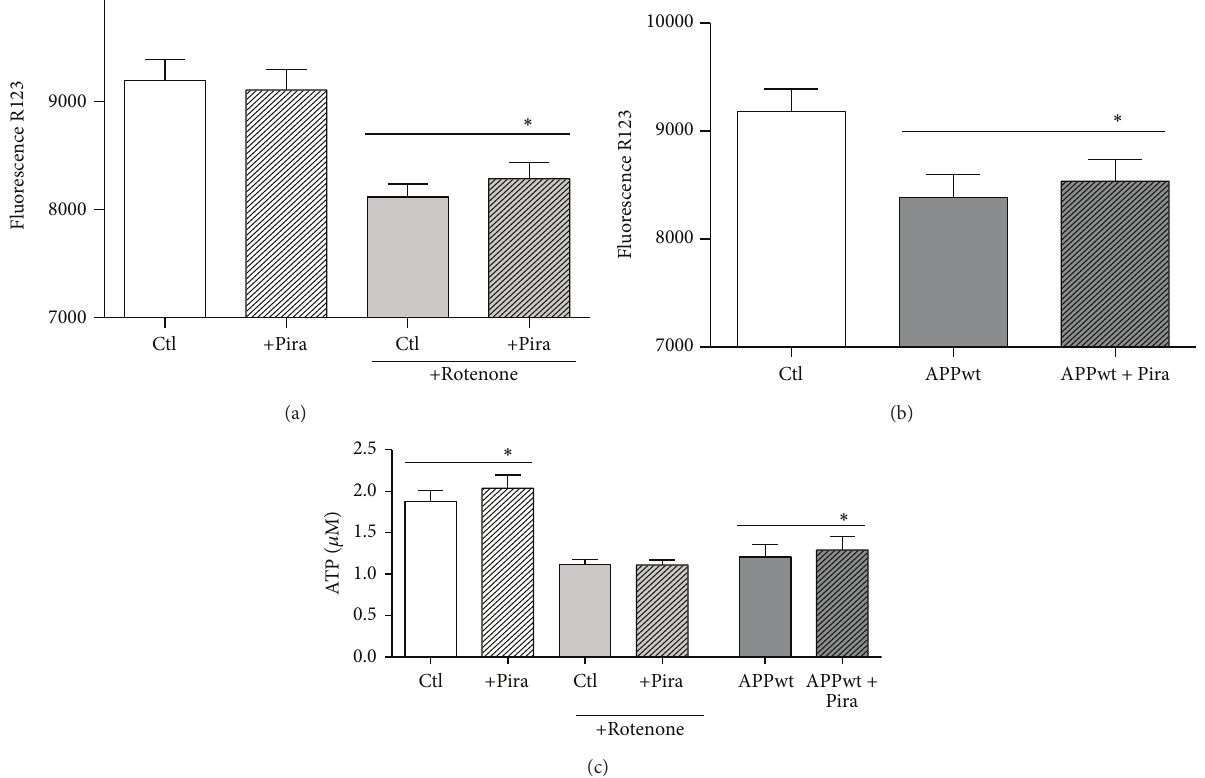
Figure 6: Mitochondrial membrane potential and ATP level are slightly elevated in piracetam treated cells. Mitochondrial membrane potential was analyzed in (a) SH-SY5Y Ctl and (b) SH-SY5Y APPwt cells using the fluorescent dye Rhodamine 123 (R123). In SH-SY5Y Ctl cells, mitochondrial membrane potential is unaltered under normal conditions but decreased after complex I inhibition induced by rotenone. In SH-SY5Y APPwt cells, the mitochondrial membrane potential is decreased and is slightly compensated by piracetam (Pira). SH-SY5Y cells were seeded and incubated for one day. Afterwards, incubation was started with 1mM piracetam (Pira) for 24 hours. After 30 minutes, 2.5 𝜇 M rotenone was added. Finally, mitochondrial membrane potential was determined. (c) Piracetam (Pira) slightly elevates ATP levels under normal conditions in SH-SY5Y Ctl and SH-SY5Y APPwt cells but has no effect in rotenone treated cells. SH-SY5Y cells were seeded and incubated with 1mM piracetam (Pira) for 72 hours. During the last 24 hours, 2.5 𝜇 M rotenone was added. Finally, ATP levels were determined. Data are represented as mean ± SEM; Student’s paired 𝑡 -test ( ∗ 𝑝 < 0.05 compared to untreated control cells or rotenone treated cells, resp.); 𝑛 =